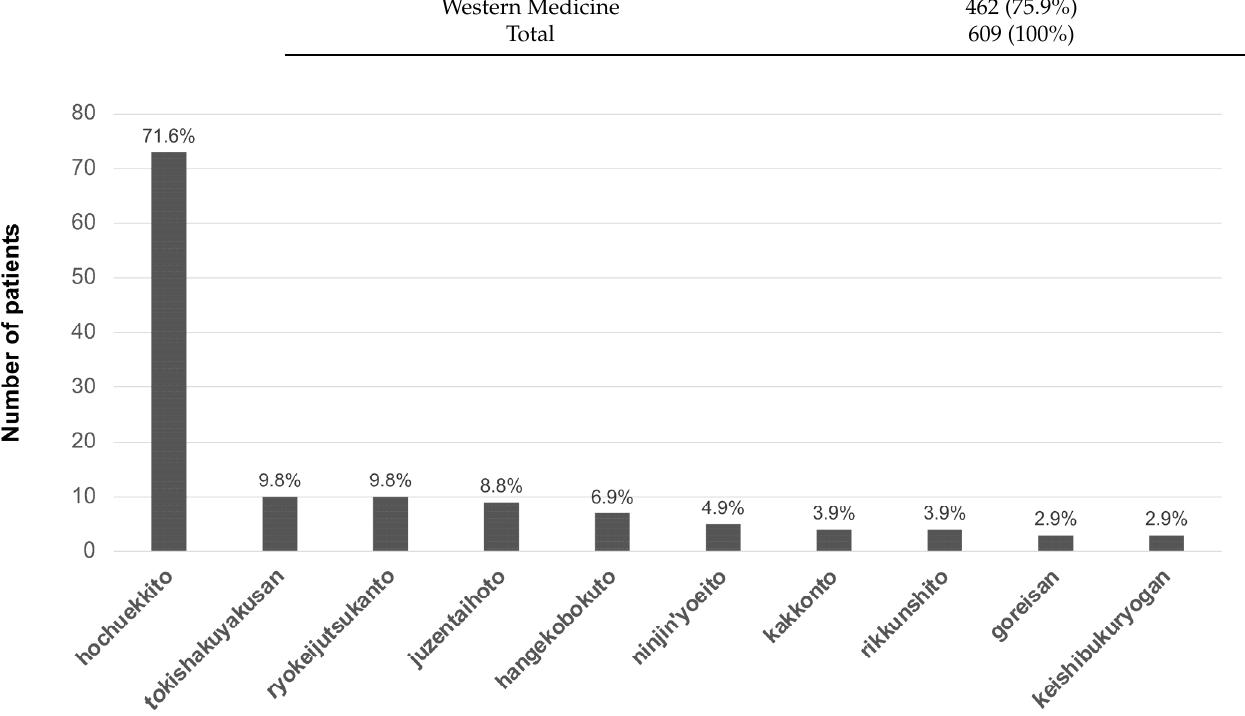
Figure 2. Number of patients receiving each Kampo medicine. The most frequently prescribed Kampo medicine was hochuekkito. Table 2. Number of prescriptions (%) for patients who visited the CAC clinic classified as Kampo medicine and Western medicine with focus on general fatigue.